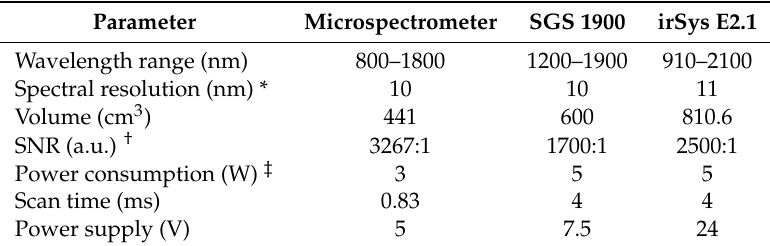
Table 5. Important parameters of the microspectrometer prototype and the corresponding values for the Hiperscan SGS 1900 and irSys E2.1 for